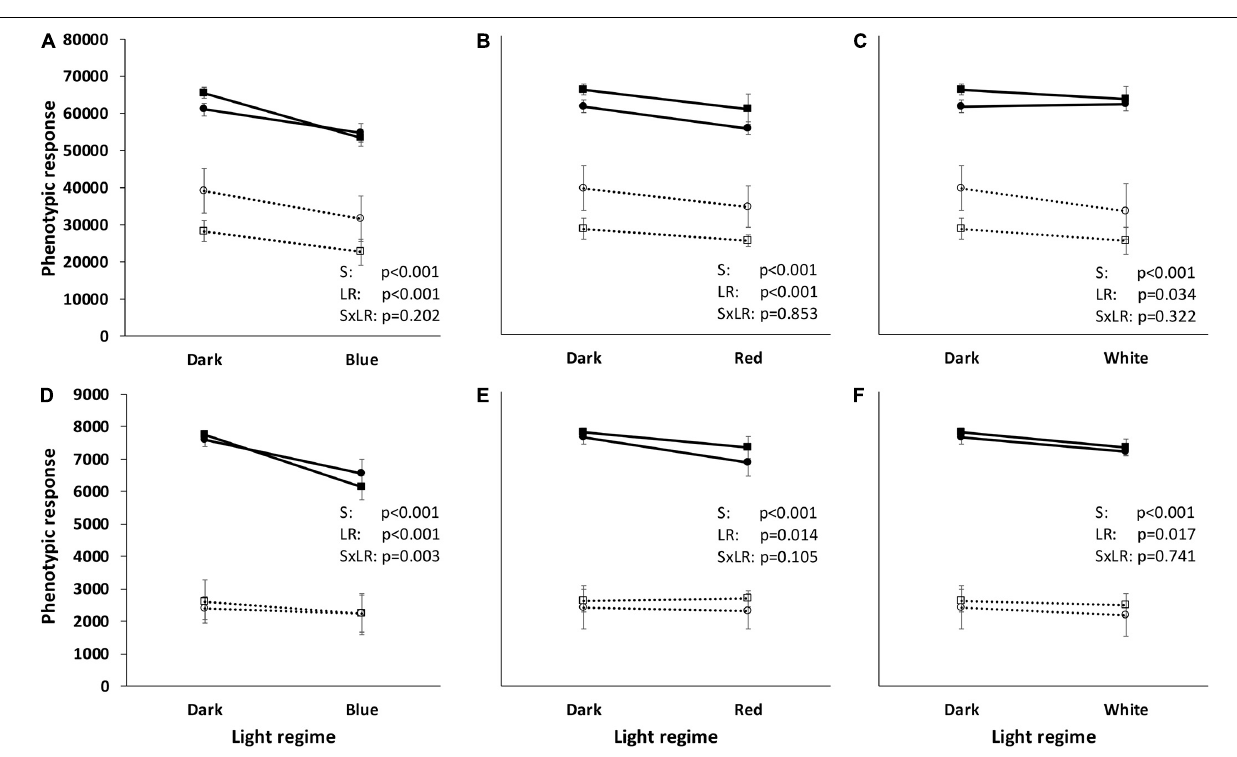
FIGURE 3 | Reaction norms of two Gram-negative ( Pseudomonas agarici : black line, black-filled circles; Pseudomonas sp. DR 5-09: black line, black-filled squares) and two Gram-positive ( Bacillus thuringiensis serovar israeliensis : black broken line, black-open circles; Streptomyces griseoviridis : black broken line, black-open squares) bacteria when exposed to different light regimes. The reaction norms are based on the phenotypic response to all 384 test substrates (A–C) and 37 test substrates (“co-catabolic subset”) (D–F) extracted from phenotypic microarrays using PM01-PM04 (Biolog, Haywood CA, United States). Total utilization was assessed by kinetic measurements of color change in the redox dye tetrazolium blue and calculated on the basis of maximum curve height (Omnilog units). Each value point corresponds to six independent replicates. Statistical information is based on ANOVA (general linear model) followed by Tukey’s test (p < 0.05) with respect to strain (S), light regime (LR), and their interaction